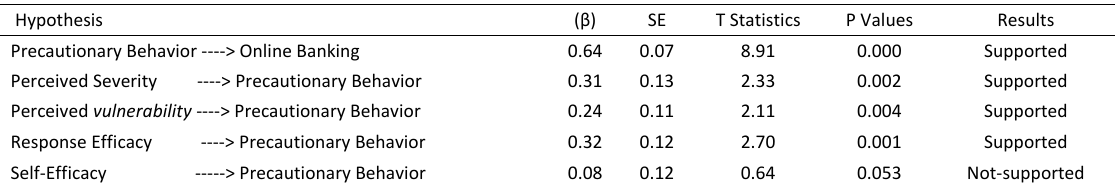
Table 3: Hypothesis results